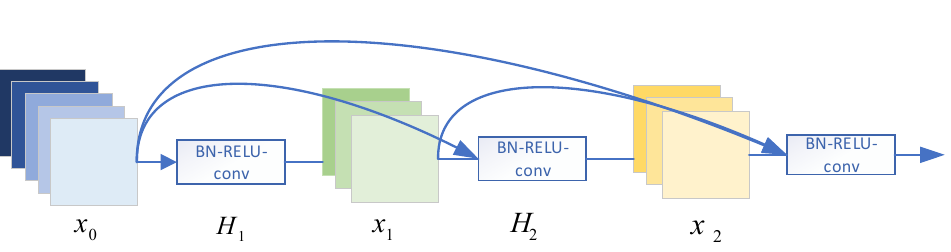
Figure 4. Three-layer dense block model.